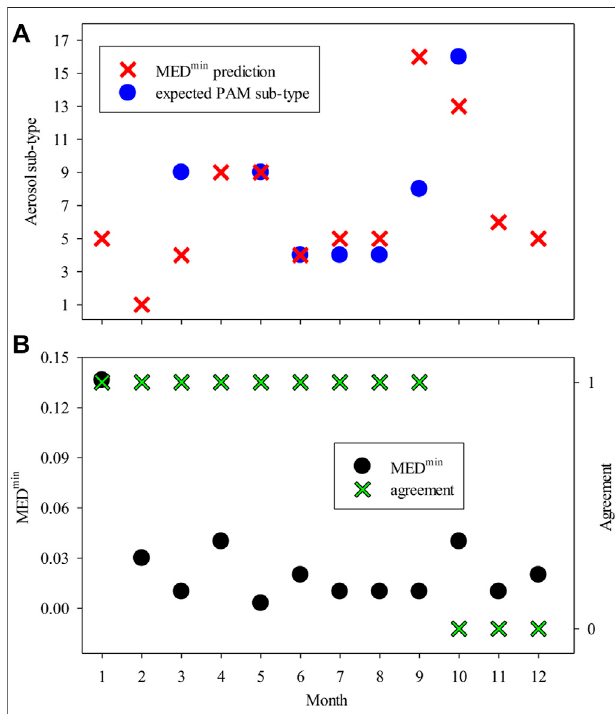
FIGURE 6 | Validation of aerosol models using MED in Solar Village. Predicted aerosol sub-types (A) , MED min prediction performance (B) . The mismatch between aerosol types is an agreement of 0. No blue circles when co-dominance is